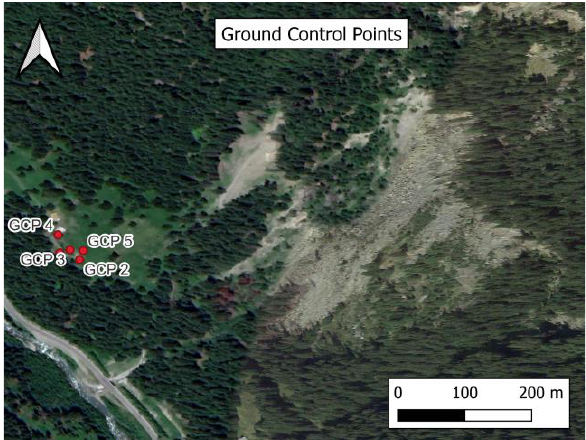
Figure 4. The location of the GCPs. ( basemap - Google Satelite through QuickMapServices QGIS plugin, Map data © Google )